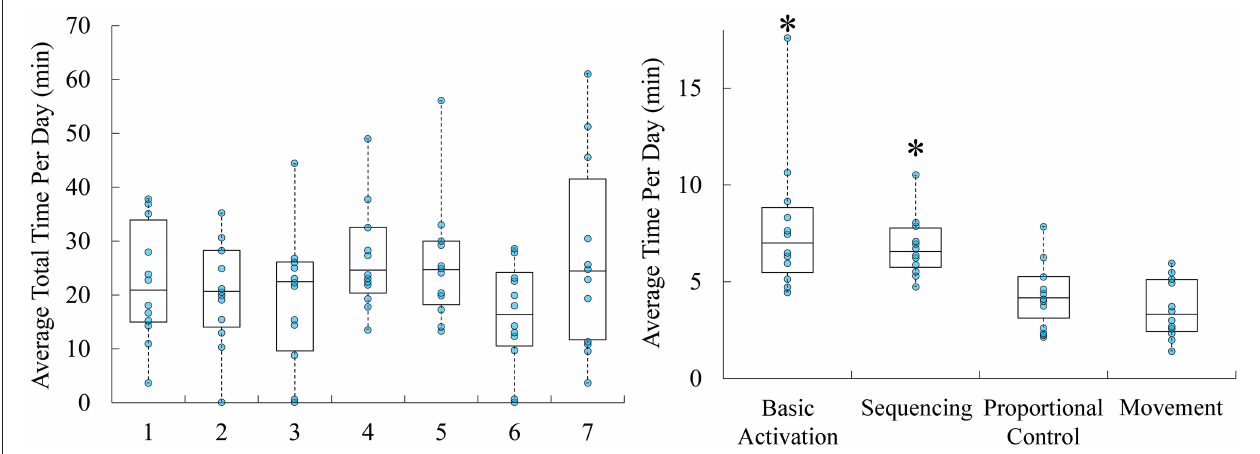
FIGURE 5 | Boxplots overlaid with raw data of average time spent training with the system per day throughout the study (days 1 through 7), and the average amount of time spent on each game per day. Time spend training per day was and average of 22.5min, with participants spending significantly more time with Volcanic Crush and Dino Sprint. * p < 0.05.